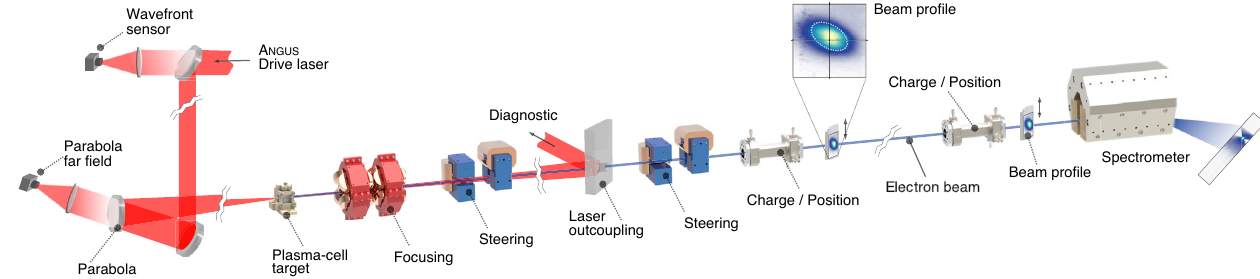
FIG. 1. The drive laser (red) is focused into a plasma-cell target, where it ionizes a nitrogen-doped hydrogen gas to form a plasma and then traps and accelerates electrons to an energy of 368 MeV. After the target, the laser is extracted from the beam axis for diagnostics. The electron beam (blue) is captured using a pair of electromagnetic quadrupoles and focused into a permanent magnet dipole spectrometer. The electron beam is adjusted to the accelerator design axis using steering dipoles. Retractable scintillating screens and cavity-type beam position monitors provide electron-beam profile, charge, and position information. For clarity, only a few of the installed laser diagnostics are shown. The whole setup is integrated into a controls system to enable live monitoring, tuning, and processing of the acquired